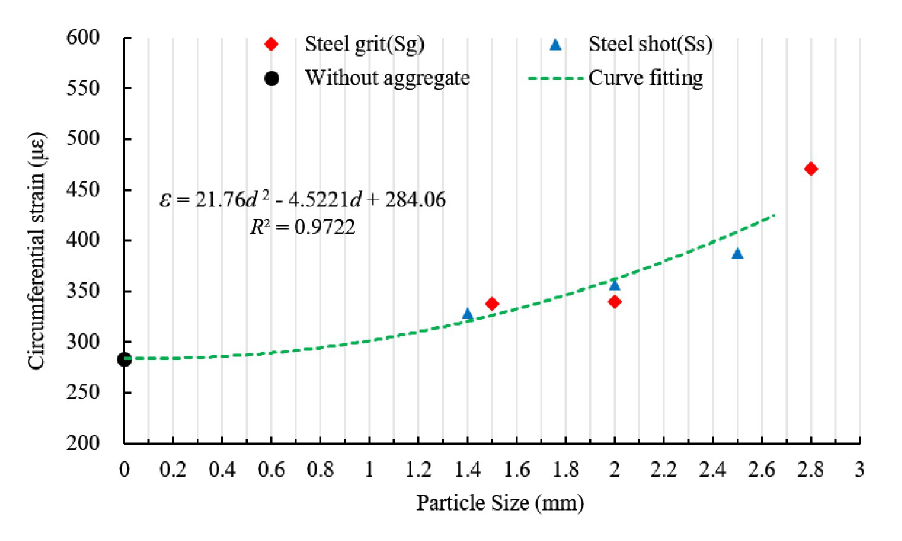
Fig 20. Scatter plot of circumferential strain and fitting curve of different aggregate